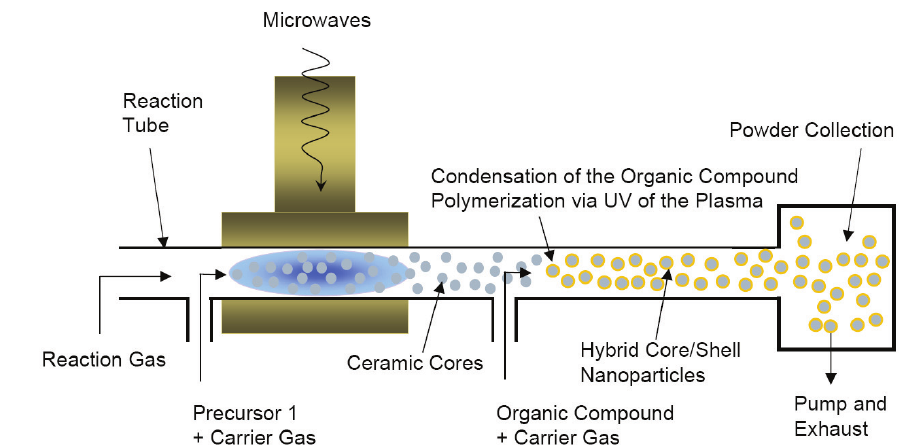
Figure 7. Set-up scheme for the microwave plasma synthesis of hybrid core/shell